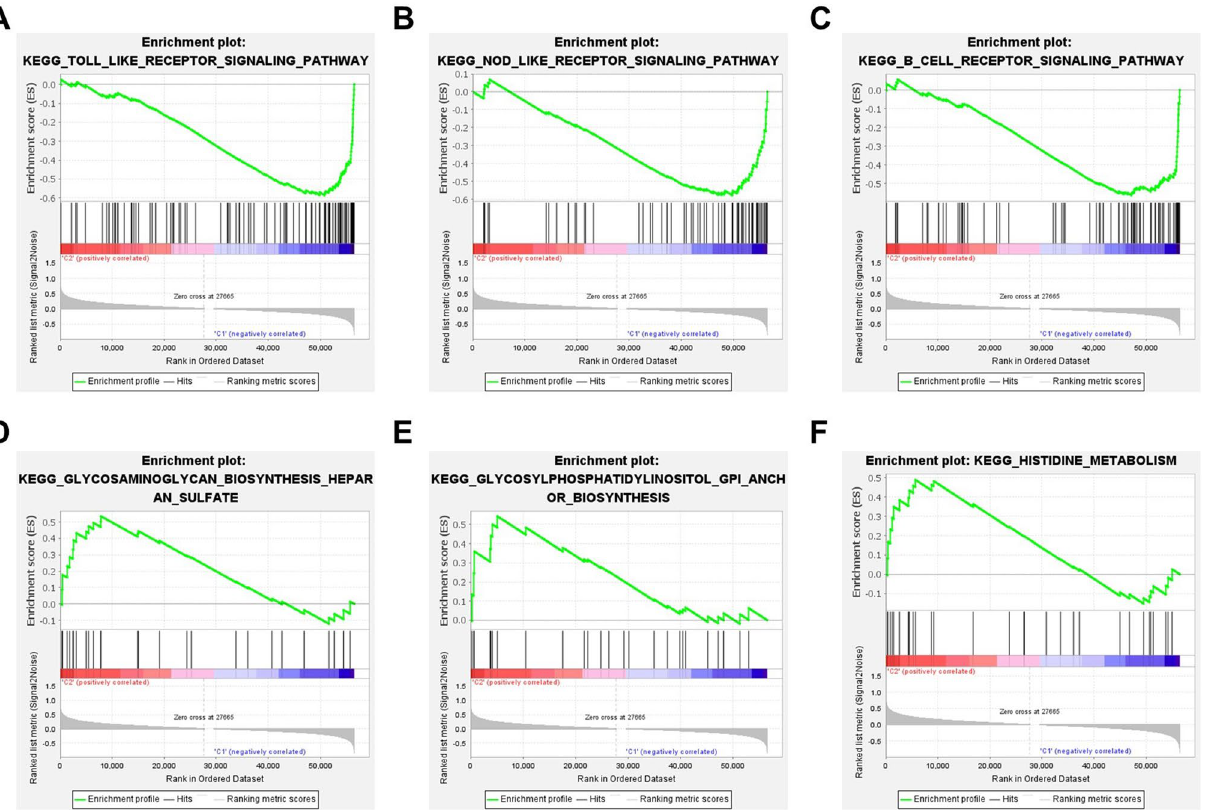
NOD-like receptor signaling pathway (ES = 0.58, P = 0.006, FDR = 0.046), B-cell receptor signaling pathway (ES = 0.56, P = 0.006, FDR = 0.044). ( D – F ) performed in cluster2. Including glycosaminoglycan biosynthesis heparan sulfate (ES = 0.54, P = 0.007, FDR = 0.039), glycosylphosphatidylinositol GPI anchor biosynthesis (ES = 0.54, P = 0.003, FDR = 0.042), histidine metabolism (ES = 0.49, P = 0.005, FDR =